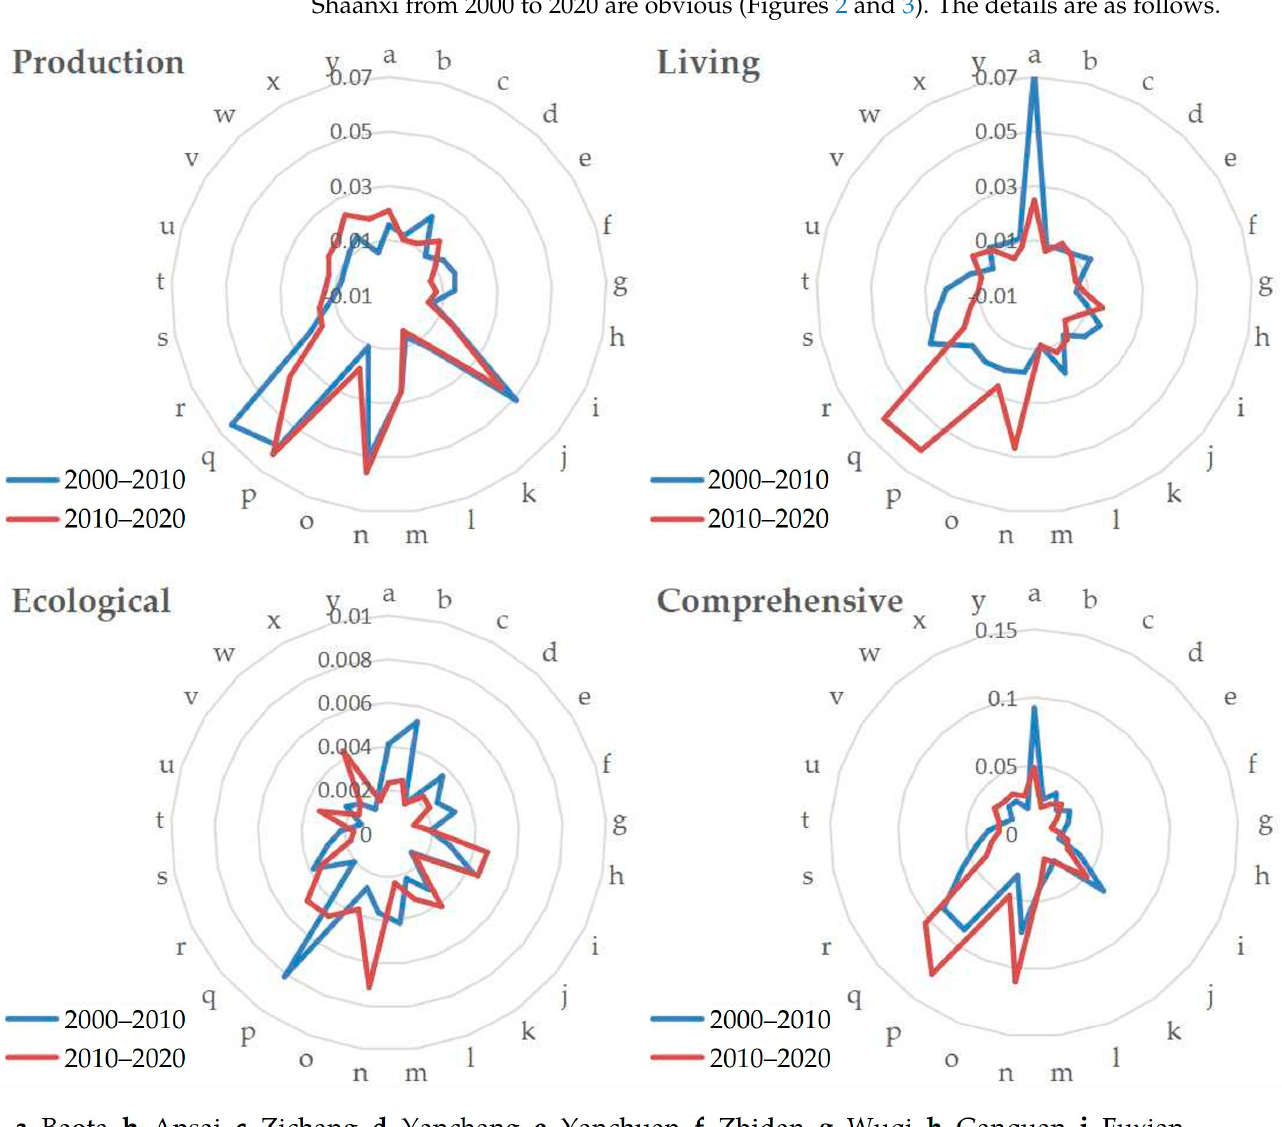
Figure 2. Production–living–ecological niche breadth change of human settlement environment in northern Shaanxi from 2000 to 2020.